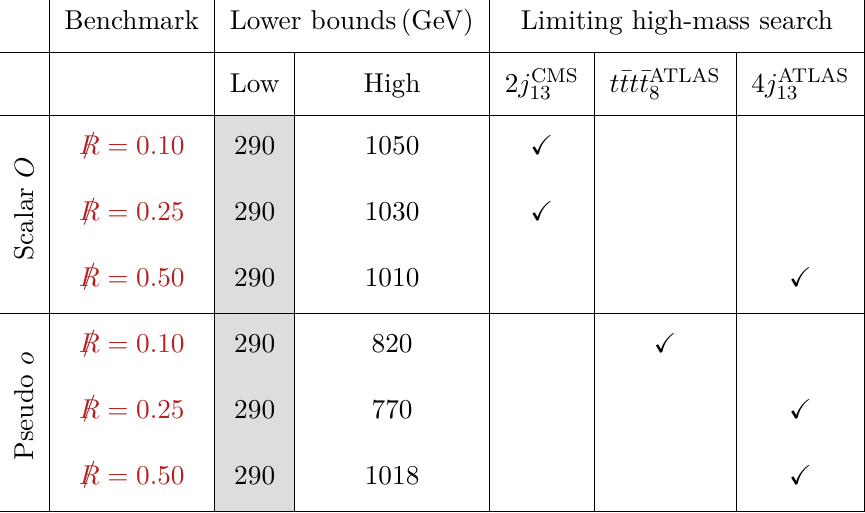
Table 4. Summary of LHC limits on sgluon masses in models with broken R symmetry. Low-mass limits shaded in gray are unaffected by R symmetry breaking. Right-hand side indicates which search imposes the high-mass limit. There may be an unconstrained gap between low-mass and high-mass limits for the scalar, but likely not for the